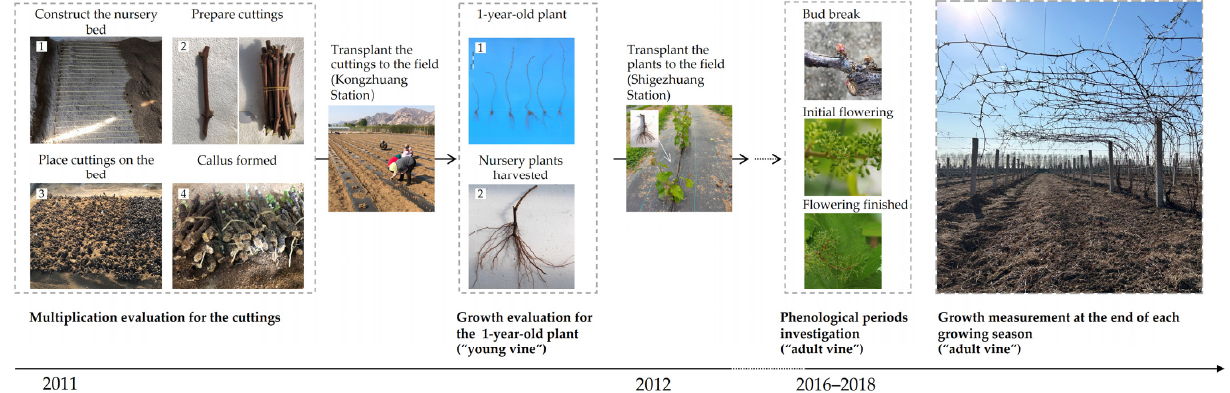
Figure 1. Schematic diagram of the present trial. The multiplication of grapevine rootstocks was evaluated after the cuttings were nursed for 30 days in 2011 and then the cuttings were transplanted into the field at Kongzhuang Station. As the “young vines” grew in the field for 90 days, both above- ground and underground growth were determined. Meanwhile, the nursery plants were harvested.